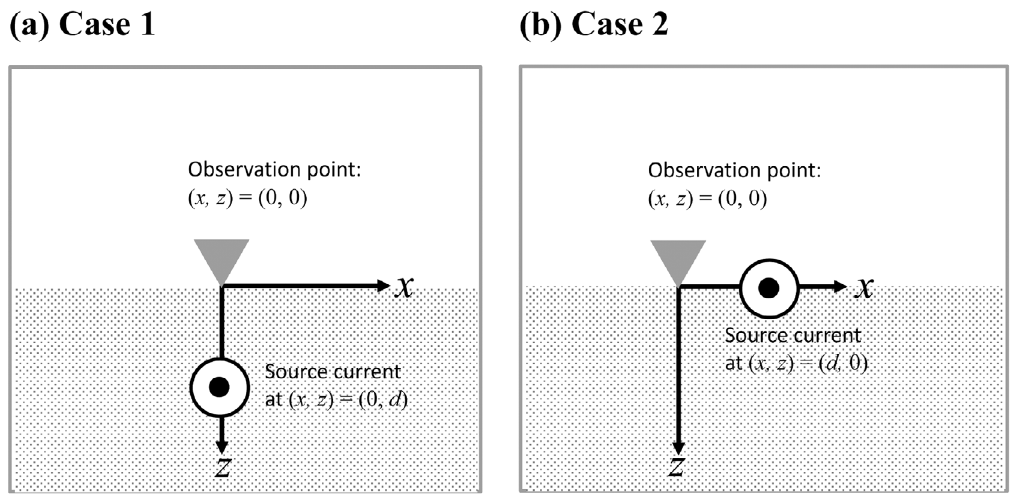
Figure 4. An illustration of the two source-receiver geometries used to test the validity of the analytical solutions developed for the two mod- els shown in Figure